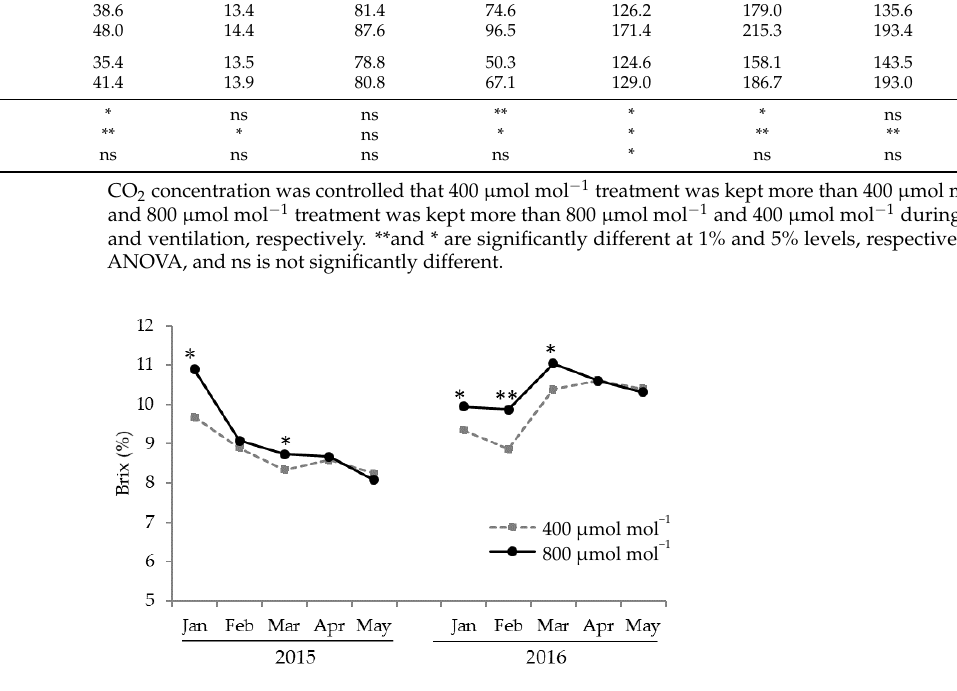
Figure 5. Effects of different concentrations of CO 2 enrichment on the fruit Brix of strawberry ‘Sagahonoka’. CO 2 concentration was controlled that 400 µmol mol −1 treatment was kept more than 400 µmol mol −1 in all day and 800 µmol mol −1 treatment was kept more than 800 µmol mol −1 and 400 µmol mol −1 during no ventilation and ventilation, respectively. * and ** are significantly different at 5% and 1% levels, respectively, by t -test.